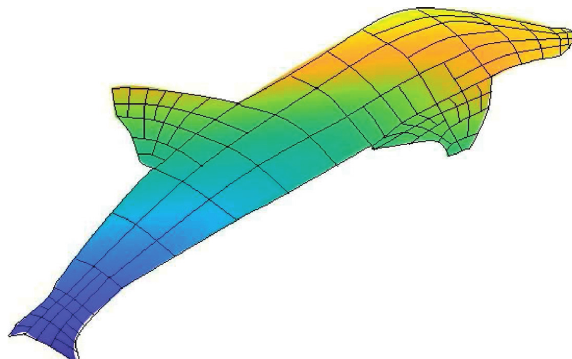
Figure 8: A dolphin model designed by the polynomial splines with control